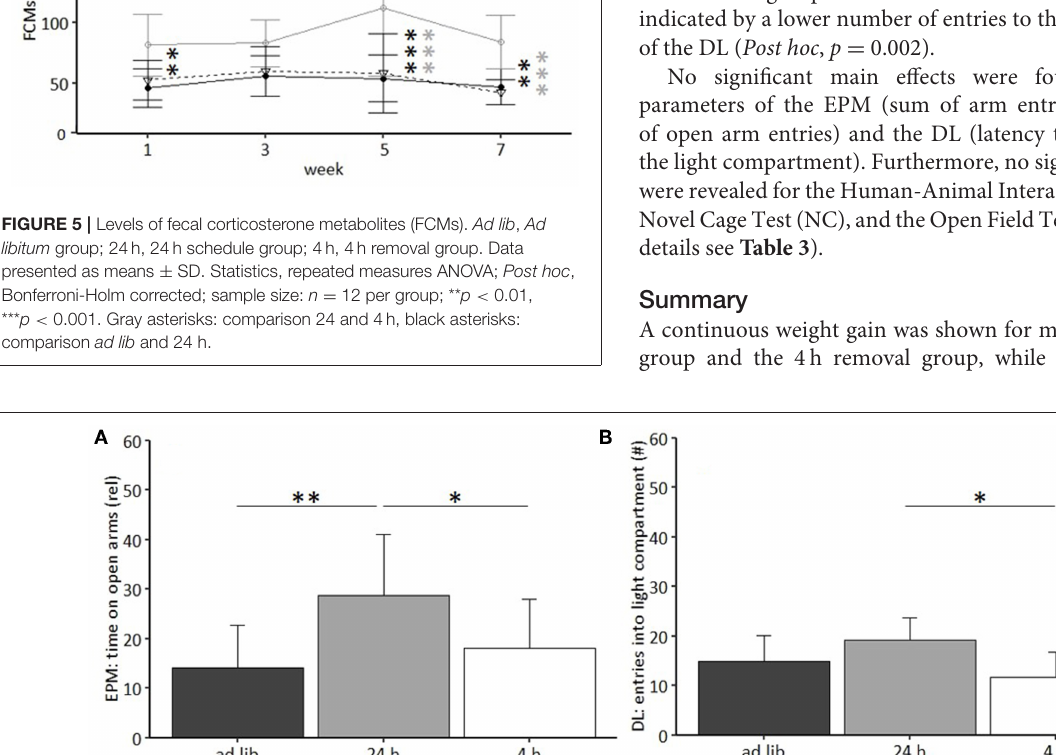
Frontiers in Veterinary Science |